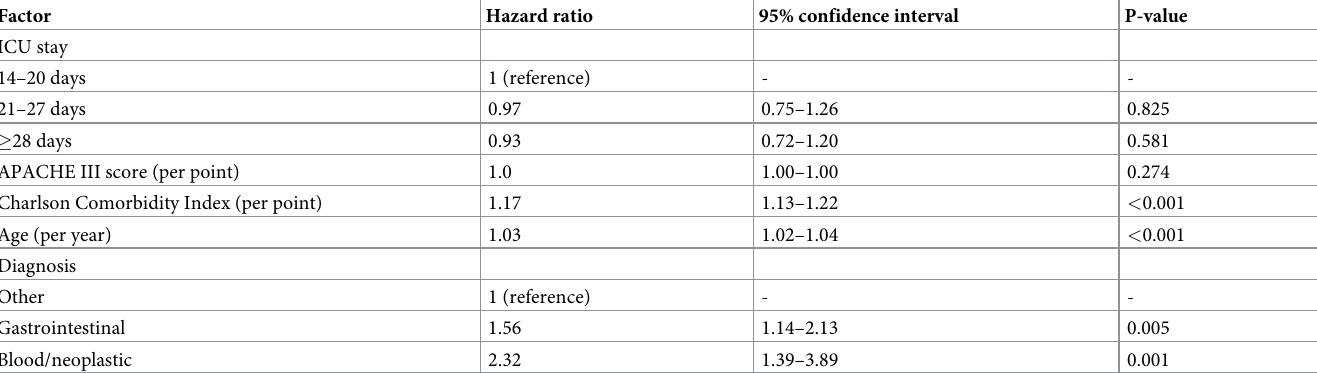
Table 3. Multivariable Cox analysis of factors associated with death among patients with prolonged admission to intensive care units. Factor Hazard ratio 95% confidence interval